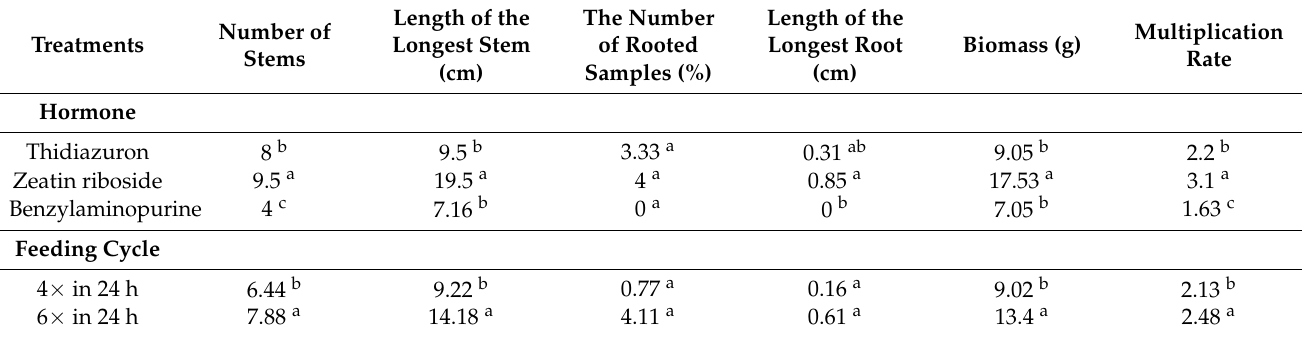
Table 4. Effect of plant growth hormone and feeding cycle in temporary immersion bioreactor system on S. pennata seedling growth